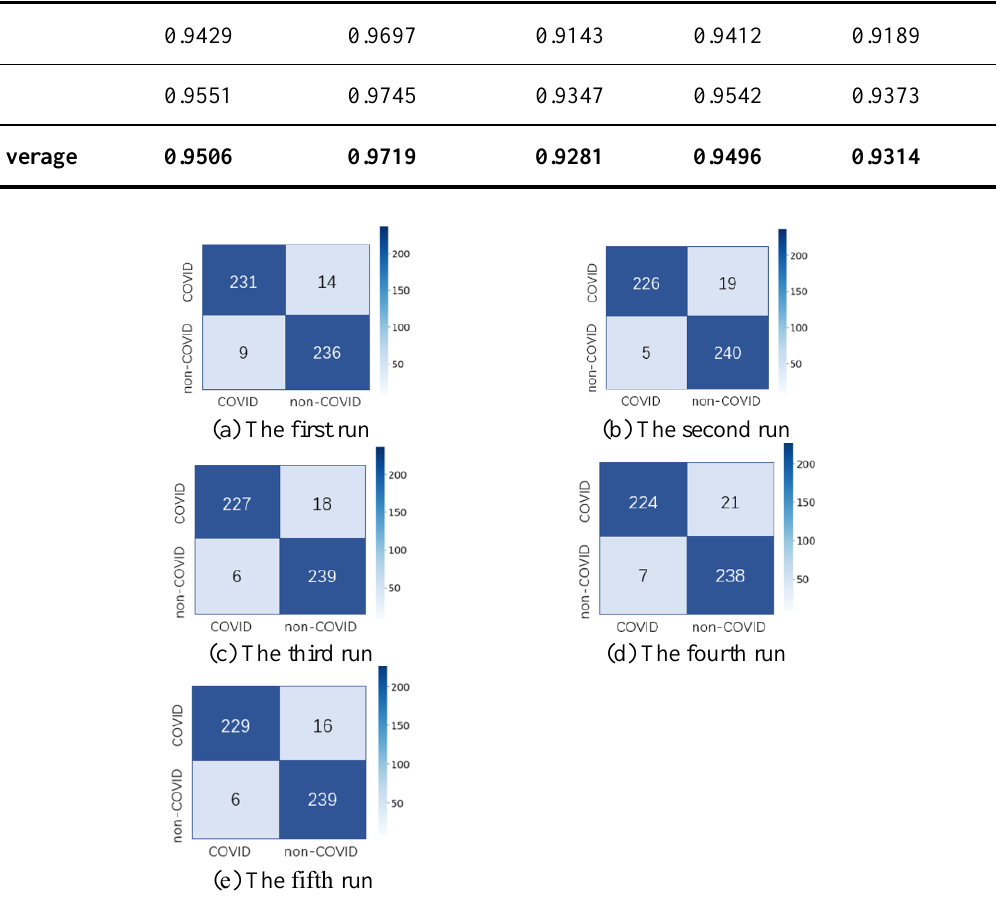
Fig. 12 Evaluation metrics comparison in five times of run